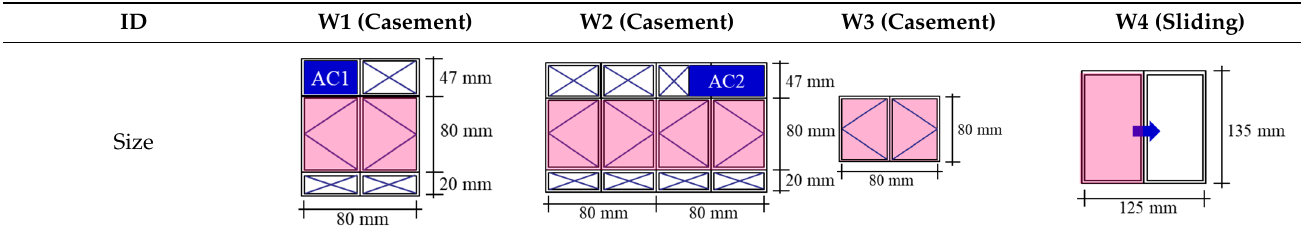
Table 2. Configurations of windows in design BIM